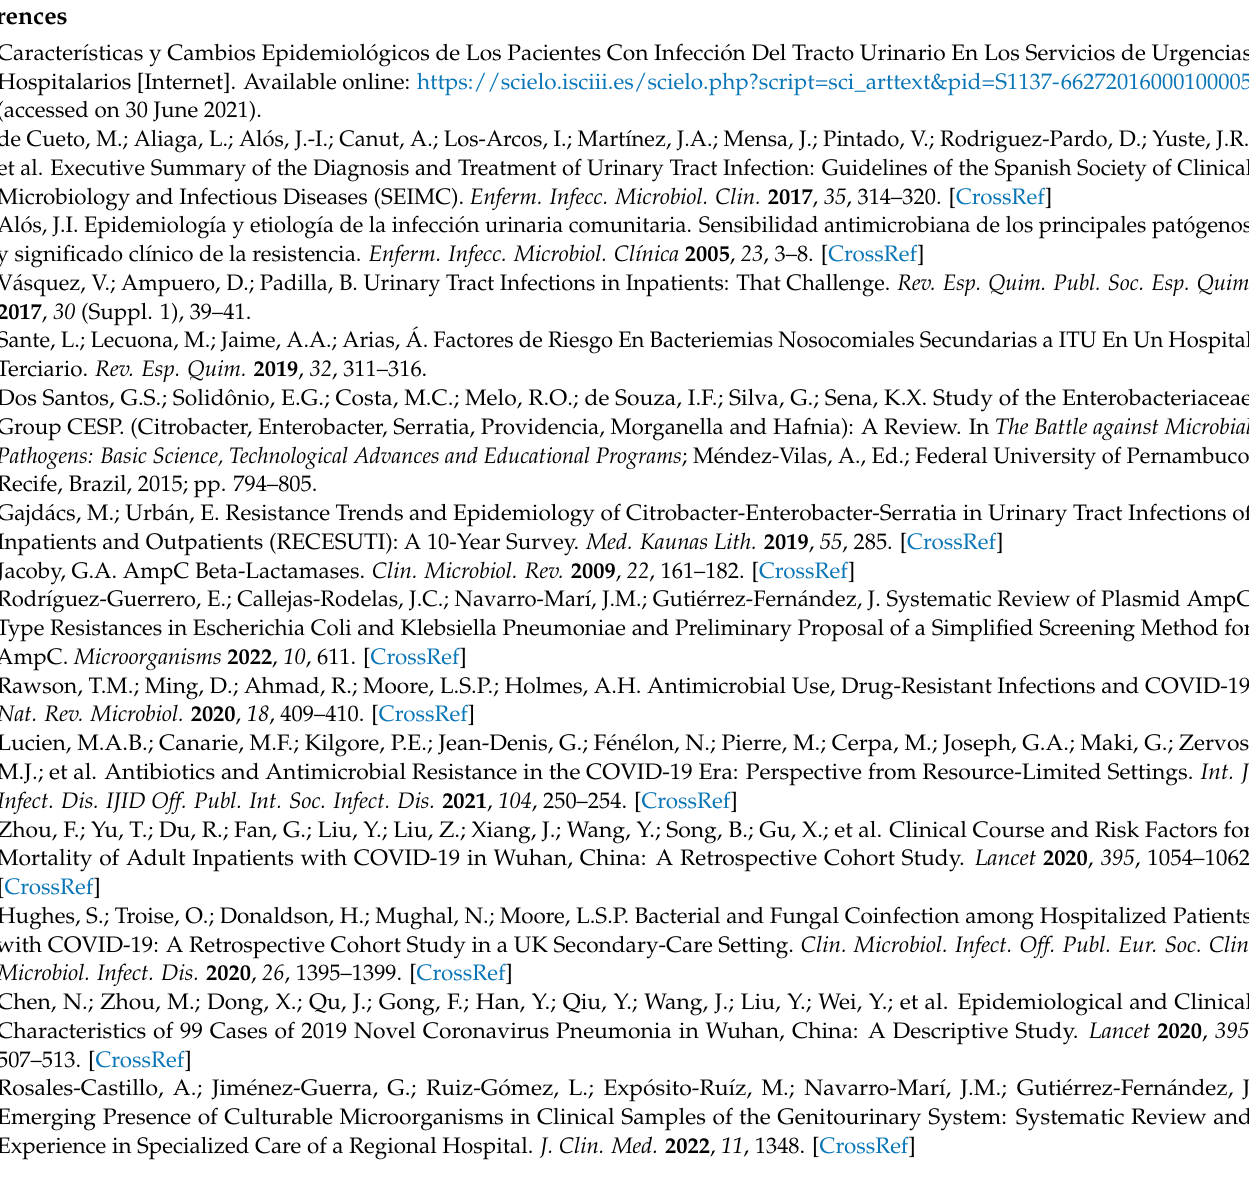
Table S81: Resistances to non-beta-lactams (%) of S. marcescens in 2018. Table S82: Resistances to non-beta-lactams (%) of S. marcescens in 2019. Table S83: Resistances to non-beta-lactams (%) of S. marcescens in 2020. Table S84: Resistances to non-beta-lactams (%) of S. marcescens in